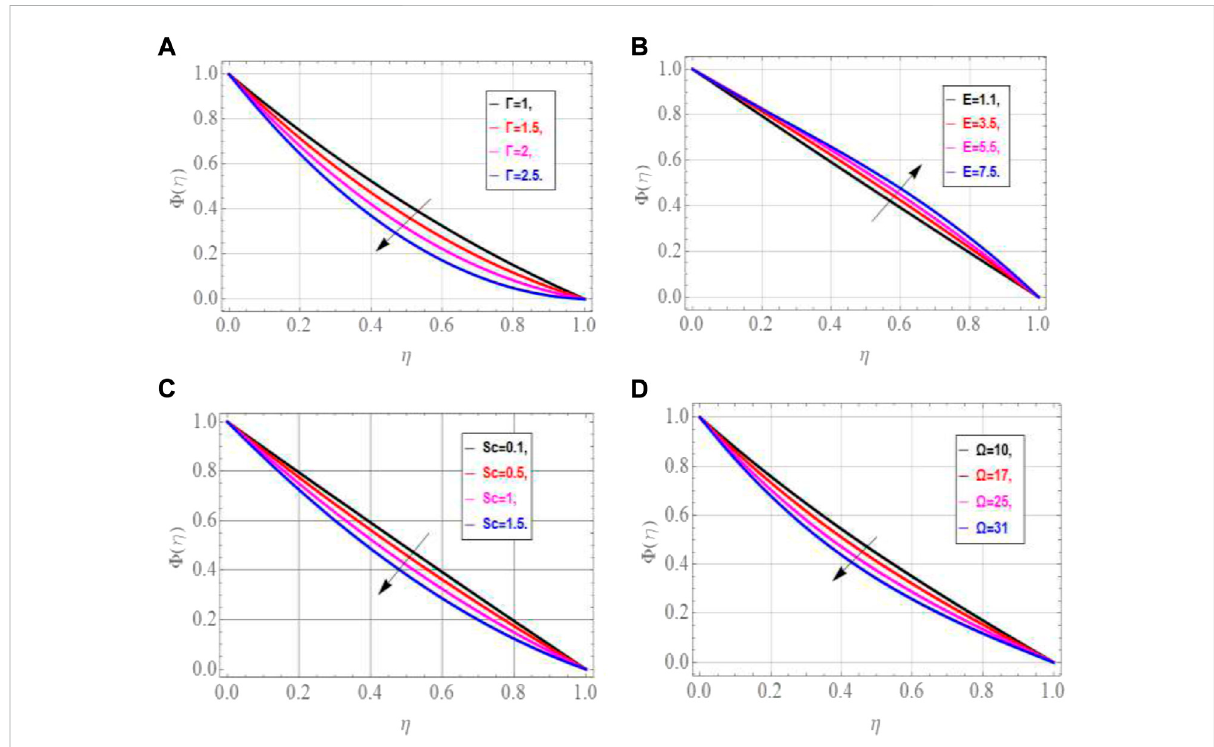
FIGURE 9 Impact of Γ , E , Sc and Ω on Φ ( η ) .